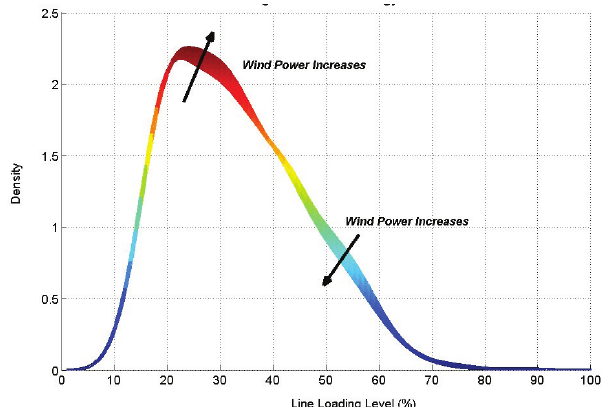
Figure 14. Impact of wind power variability on loading level in the FirstEnergy/PJM transmission system.